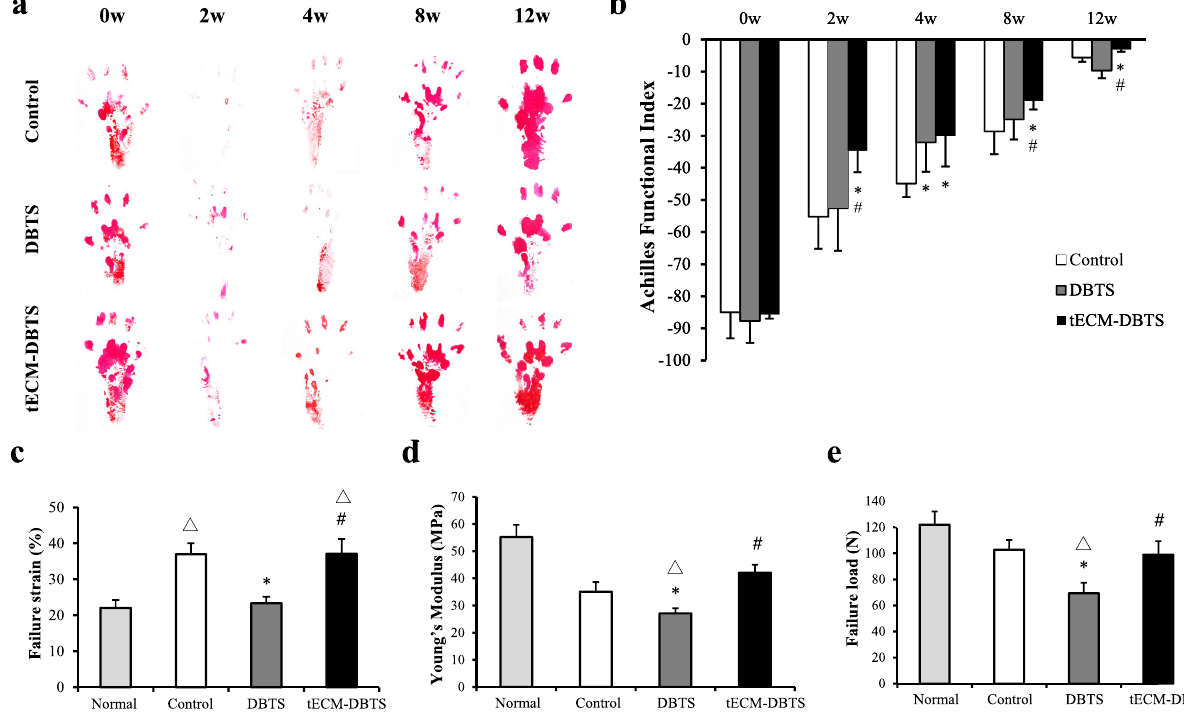
Fig. 8 Functional and biomechanical testing of the control, DBTS and tECM-DBTS implant. a The paw prints of the control, DBTS and tECM- DBTS group pre-operative (0w) and post-operative at 2, 4, 8 and 12 weeks. b Functional testing of the Achilles tendon over 12 weeks was performed to assess recovery of motion ( n = 4). c The failure strain, ( d ) Young ’ s modulus and ( e ) failure load of the different groups ( n = 4). Δ Signi fi es a p < 0.05 as compared to the normal tendon. *Signi fi es a p < 0.05 as compared to the control. # Signi fi es a p < 0.05 as compared to the